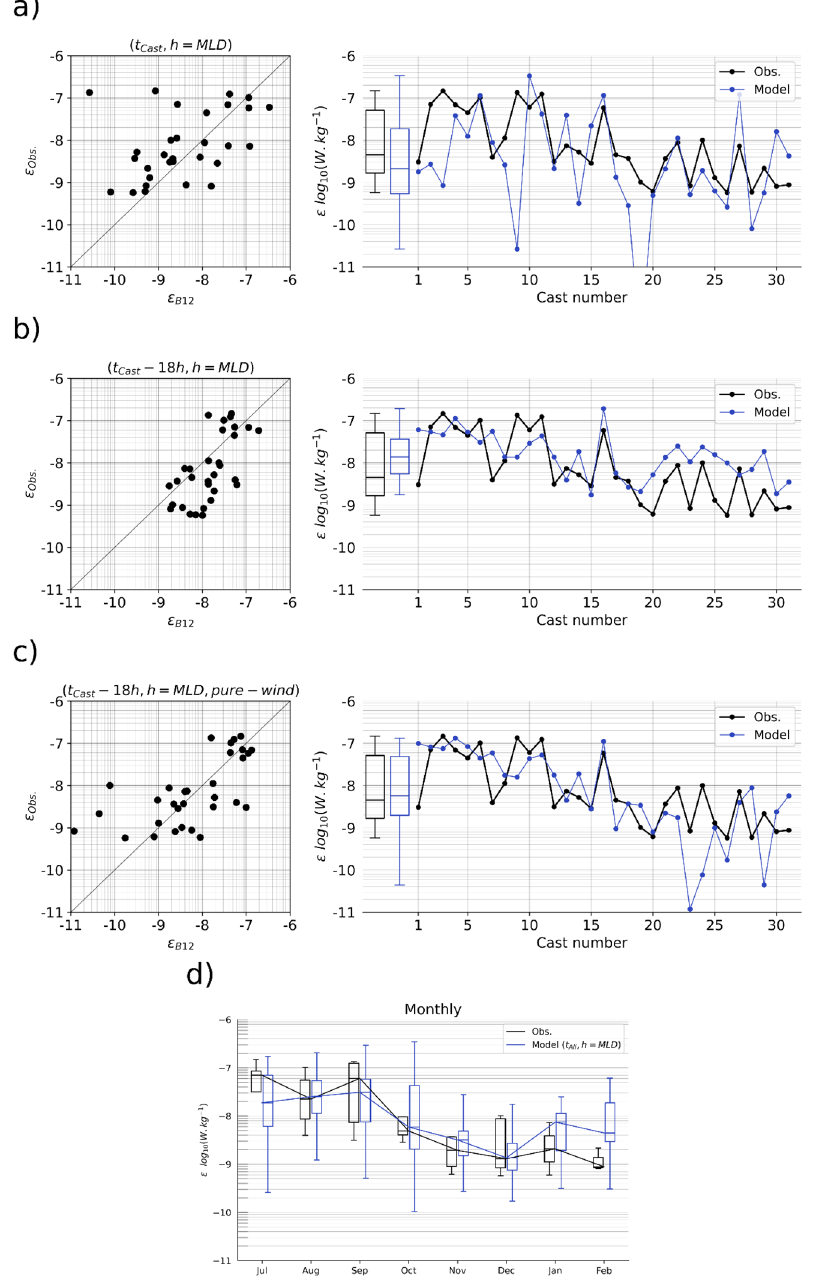
Figure 7. Comparisons between observations and models. ( Left ) Scatterplots ( ε Obs , ε Model ); ( right ) boxplots and sequences of values (black: observation; blue: model). To confront the observations, ε Model is evaluated at h = MLD , at t = t Cast ( a ), t = t Cast − 18 h ( b ), and t = t Cast − 18 h using only the wind term ( c ). For each ε Model distribution, a mean factor has been applied: mf = 2.88 on ( a ), mf = 1.91 on ( b ) and mf = 1.55 on ( c ). ( d ) Monthly distributions of ε . To estimate the model, all the days of the survey (July 2015–February 2016) are considered (i.e., not only calm sea moments). Model is corrected with mf =